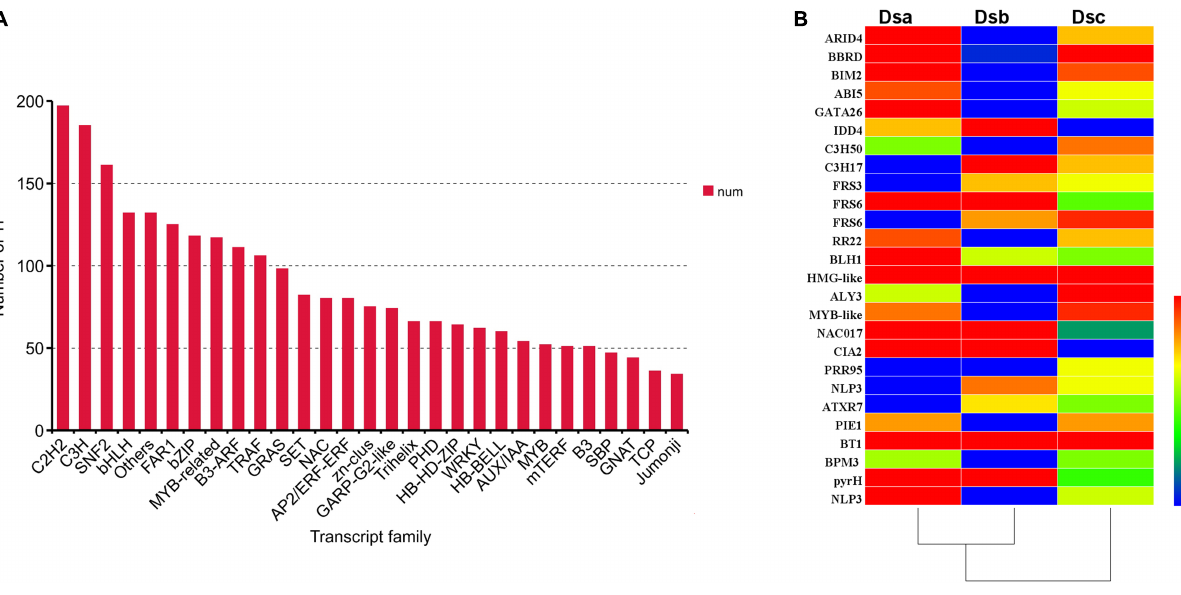
FIGURE 5 | TFs involved in response to drought stress. (A) Number of TFs in different families. (B) Heat map presenting the expression patterns of different TFs in response to drought treatments. Red denotes TFs with high expression levels, and blue means low expression. The color ranges from red to blue represents the log 2 (FPKM + 0.01) value from large too small.